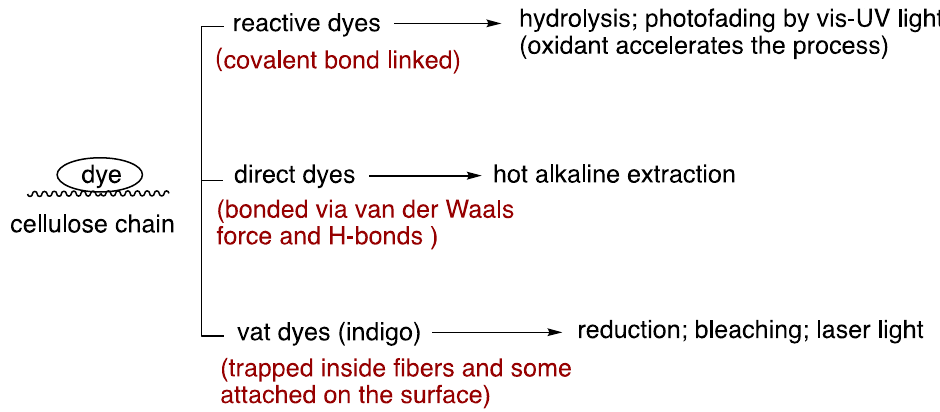
Figure 5. Summary of methods for chemical dye removal from cotton (complied from refs. [67,89–95]).